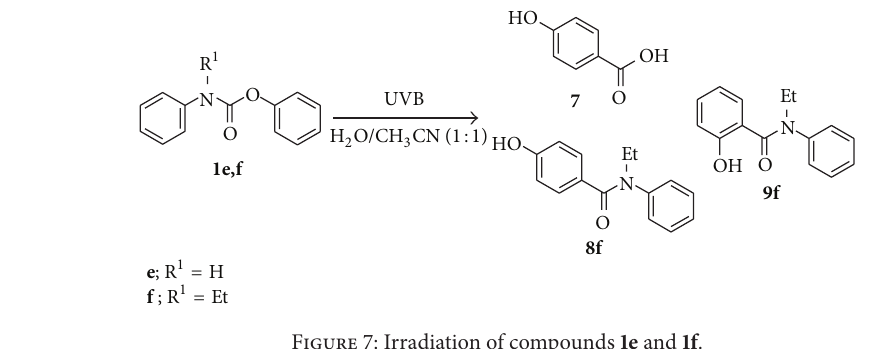
Figure 7: Irradiation of compounds 1e and 1f .